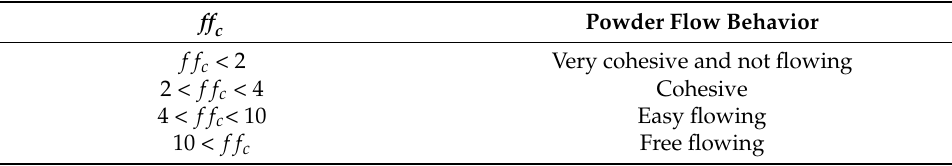
Table 3. Powder flow behavior according to Jenike